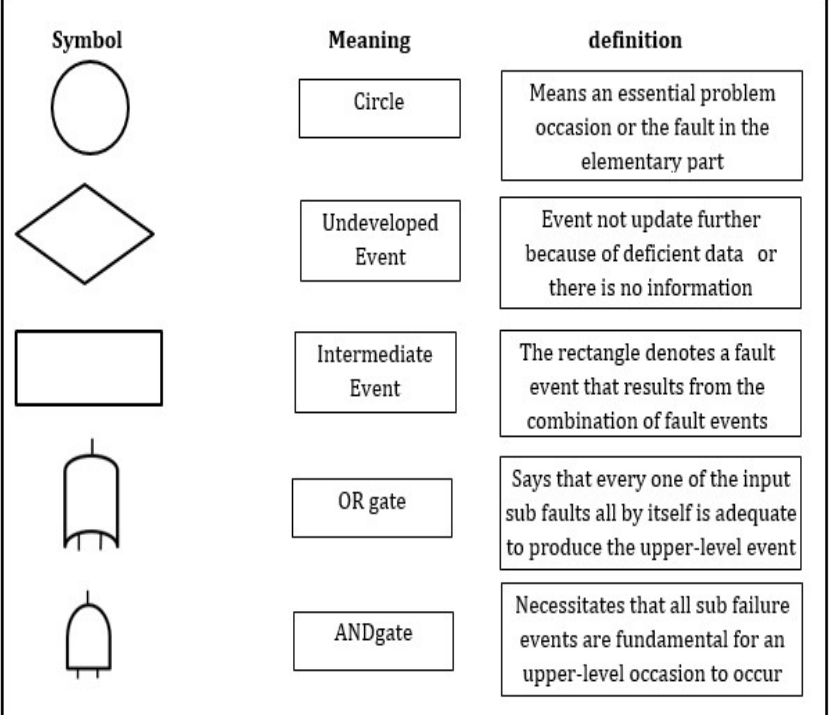
Fig.1. The fault tree